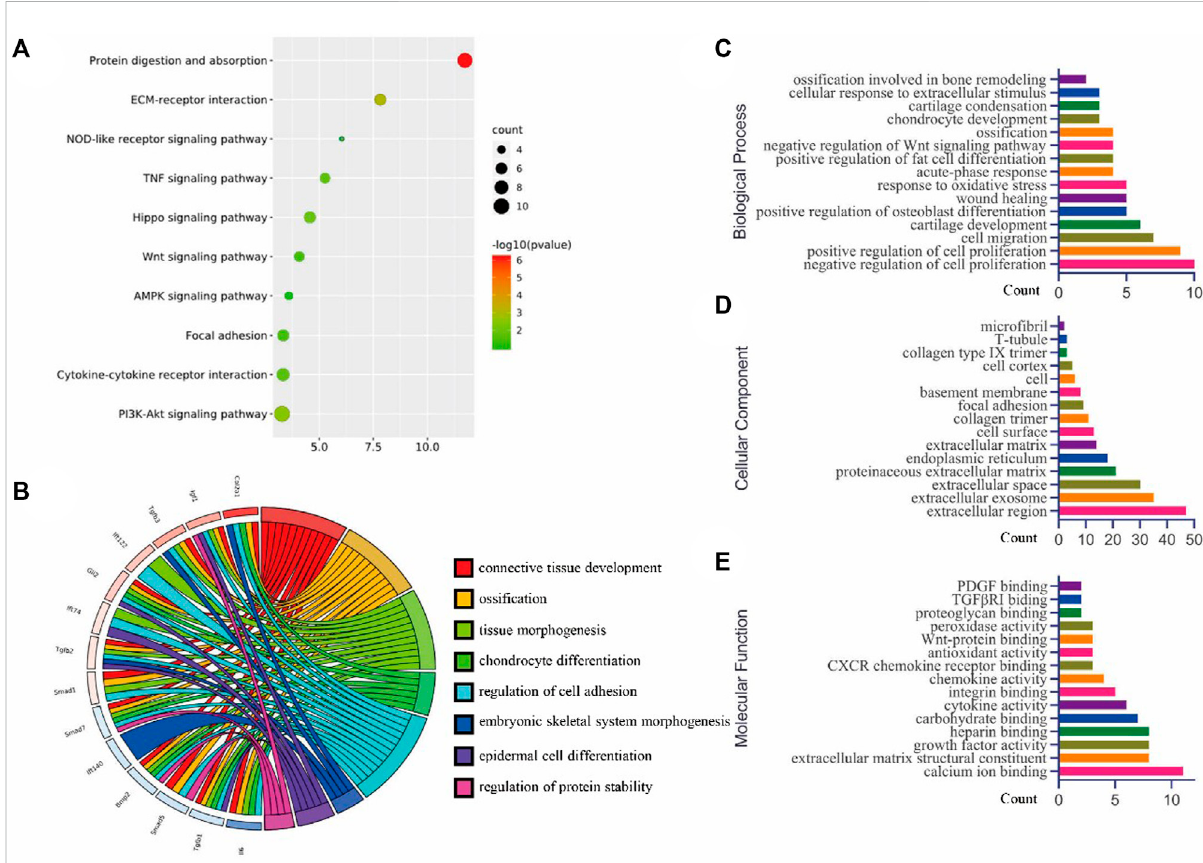
FIGURE 4 Bioinformatics analysis (GSE17825) for the top 250 genes (according to p -values) were analyzed using DAVID for (A) KEGG pathway, (B) the chord plot for some key genes and related GO terms, (C) the biological processes of GO analysis, (D) the cellular component of GO analysis, and (E) the molecular function of GO analysis ( fi gures were plotted by https://www.bioinformatics.com.cn (last accessed on 30 July 2022), an online platform for data analysis and visualization).